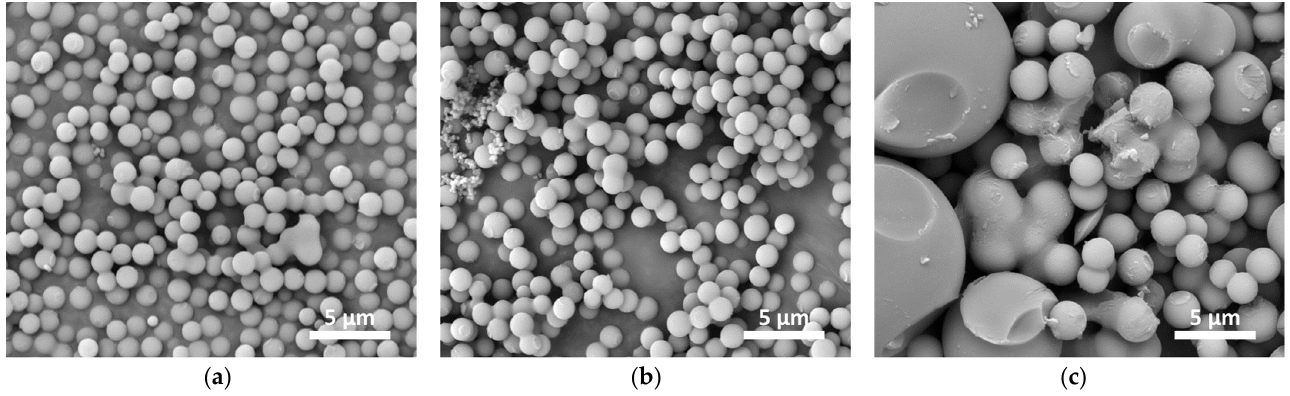
Figure 1. SEM images of HTC materials catalyzed using ( a ) hydrochloric acid, ( b ) formic acid, and ( c ) citric acid.